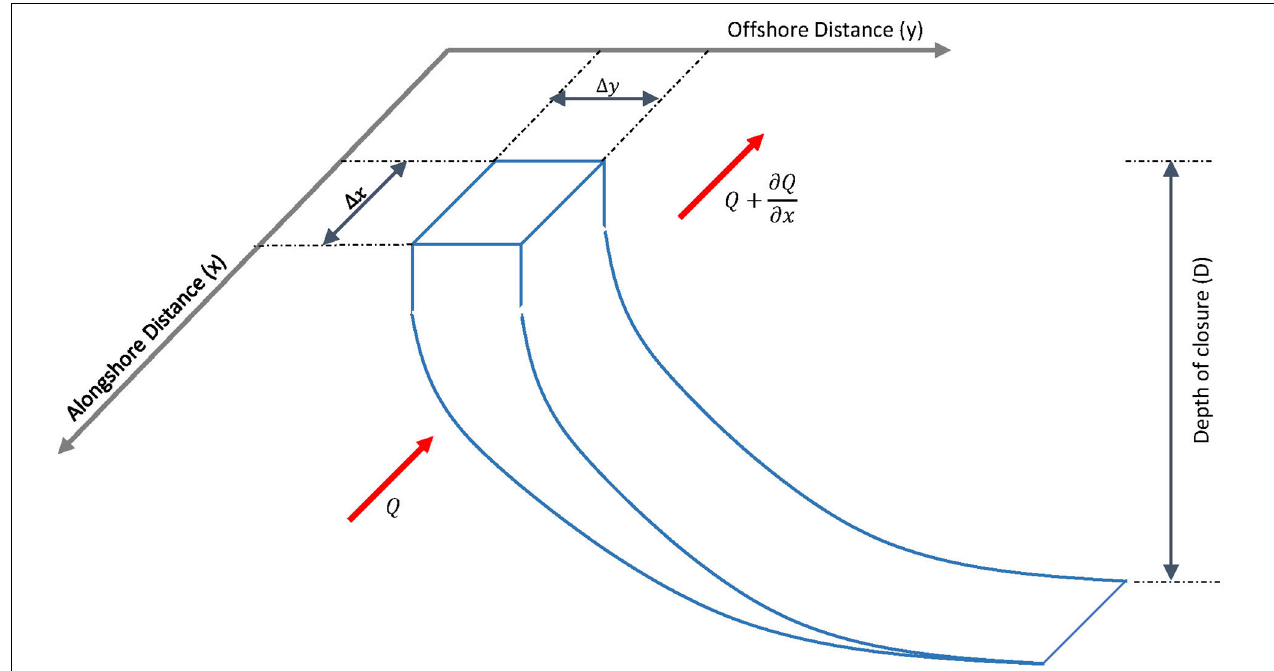
FIGURE 4 | Schematic illustration of a hypothetical equilibrium cross-shore profile and the variables used in developing the one-line coastline change